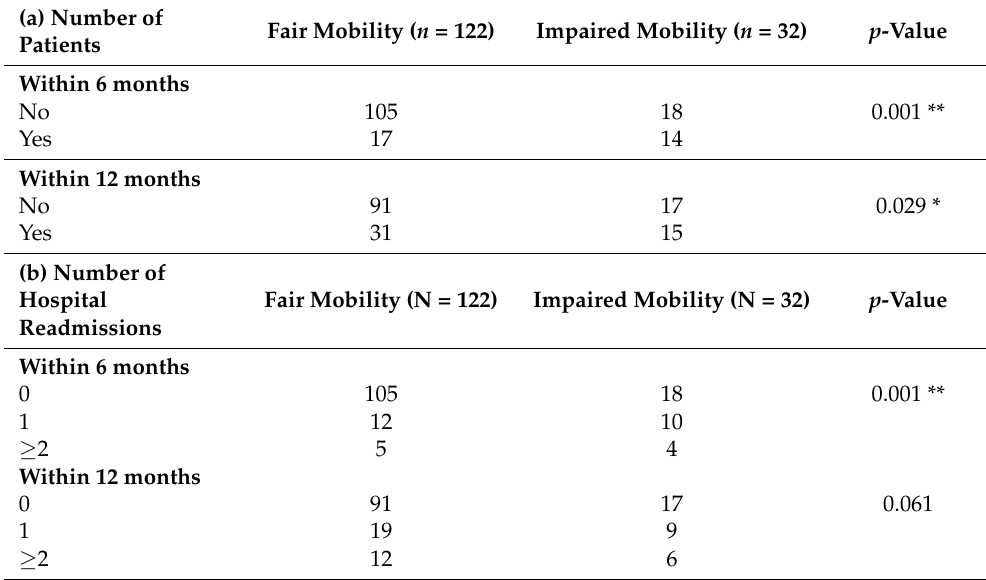
Table 3. Number of patients and number of cardiovascular rehospitalizations within 6 and 12 months after cardiac rehabilitation.